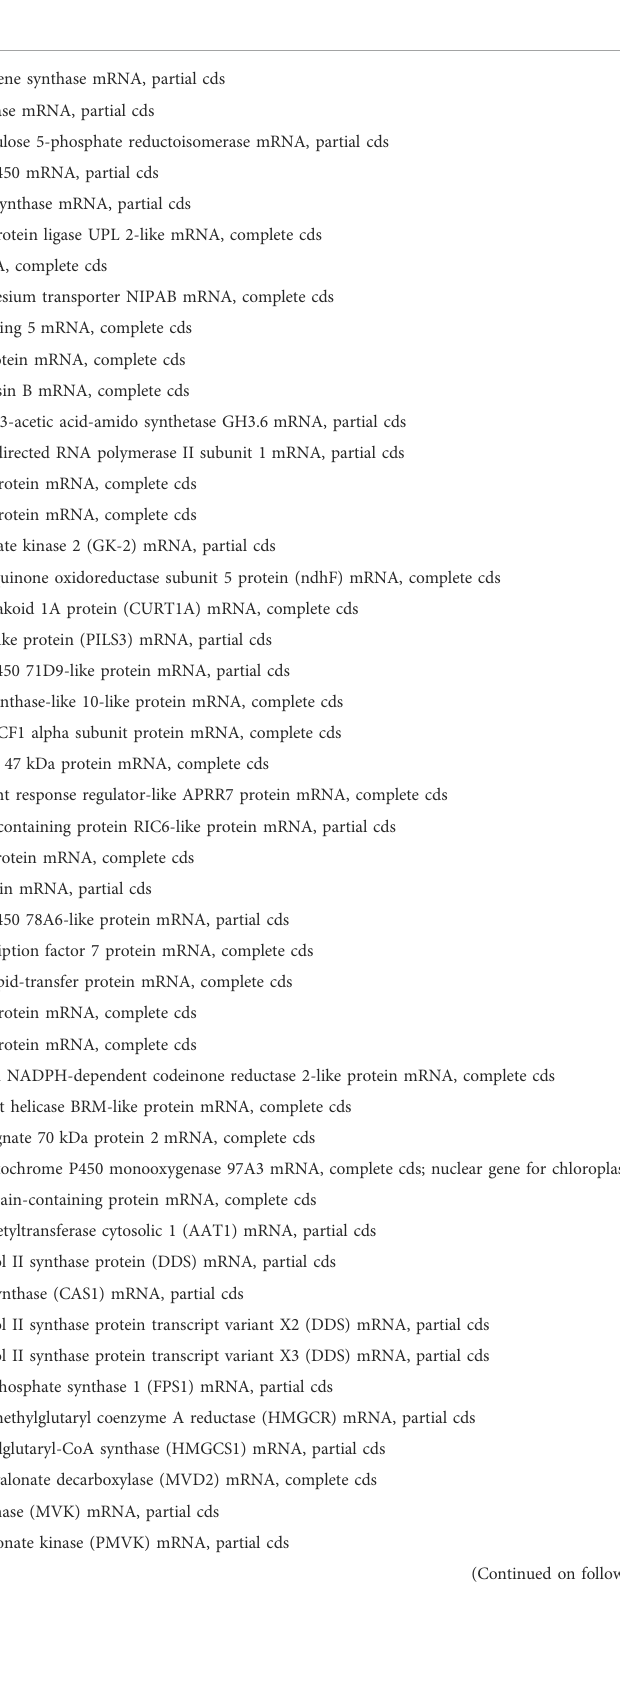
TABLE 8 List of sequences identi fi ed in Oliveria decumbens in this research so far and deposited to the NCBI